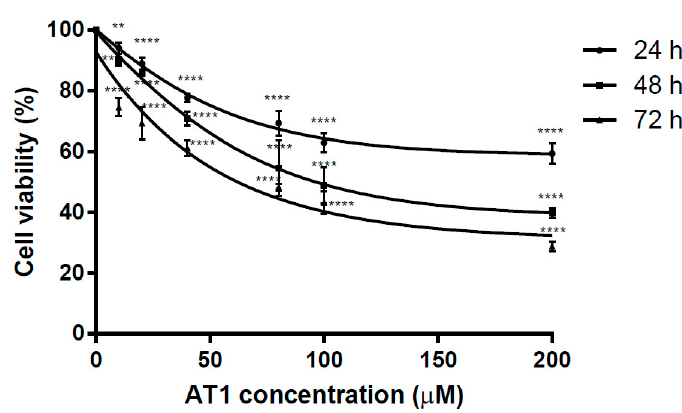
Figure 2. The anti-proliferative effect of various AT-1 concentrations on the HT-29 cell line, after treatment for 24, 48 and 72 h. Data are shown as mean ± SD, n = 6. Significant differences are indicated by ** p < 0.01 and **** p < 0.0001 as compared with the control group.